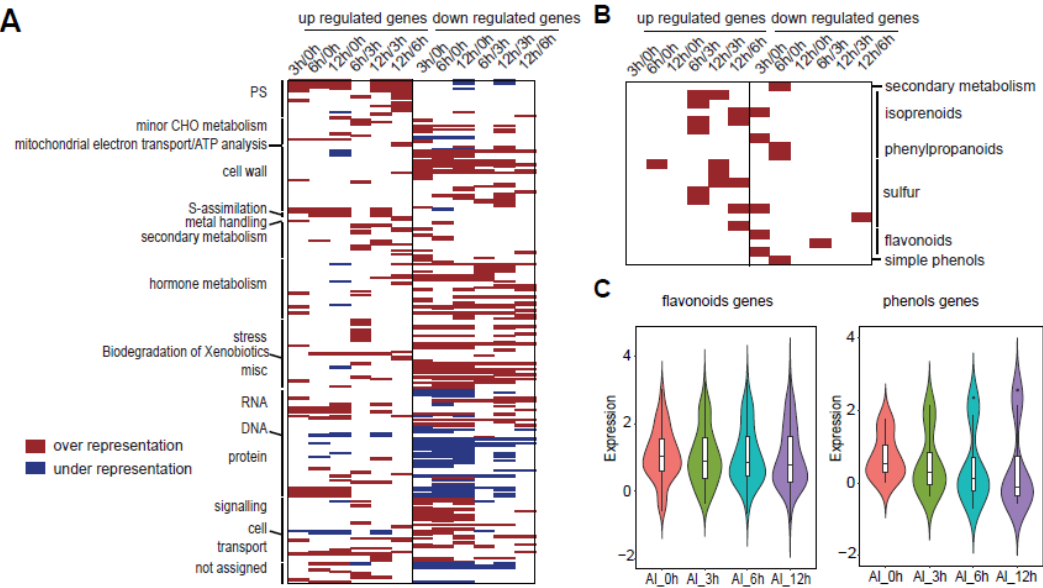
Figure 5. Key cluster (clusters 1–3 and 5) gene enriched pathways found by Mapman. ( A ) The total enriched pathways for these key cluster genes. Datapoints in each bin which exceeded the value of 1.0 were tested for over- or under-representation using Fisher’s exact test. Red represents the over-representation of genes in the corresponding pathways compared with the reference annotation. Blue represents the under-representation of genes in the corresponding pathways compared with the reference annotation. The genes were separated into two parts, which were upregulated and downregulated genes. ( B ) The magnification of metabolic pathways containing important flavonoid and simple phenol pathways. ( C ) The expression pattern of flavonoid-related genes and phenol-related genes extracted from ( B ). The y axis is for the lg(FPKM) in each time point.